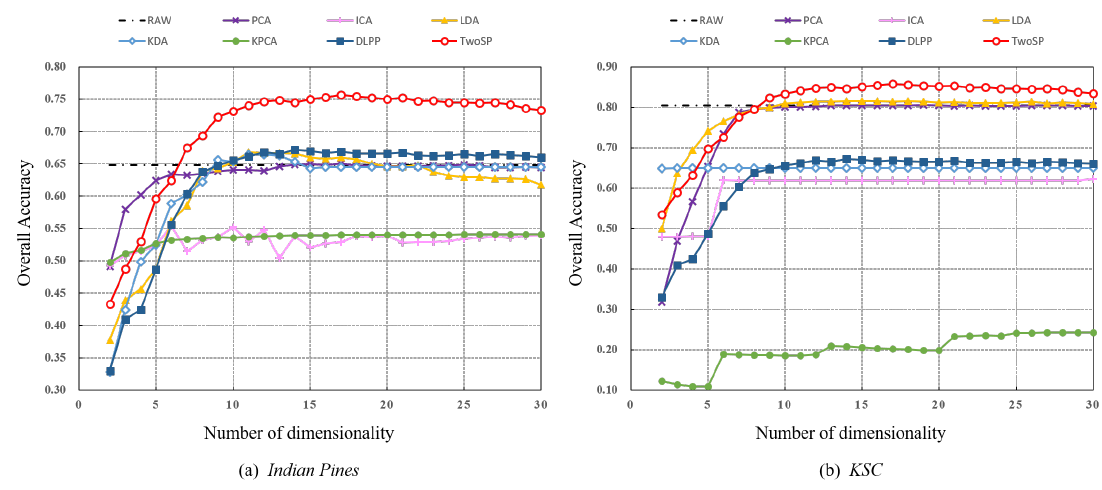
Figure 3. Overall Accuracy (OA) obtained by the NN classifier versus the reduced dimensionality of various different methods on two real-world HSI datasets, i.e., ( a ) Indian Pines and ( b ) KSC .